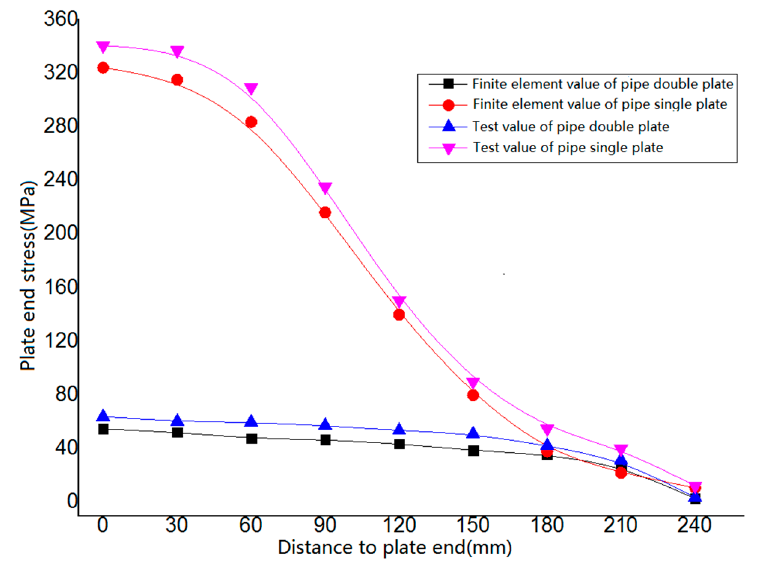
Figure 19. Comparison of bending stress test value and finite element value of plate end.